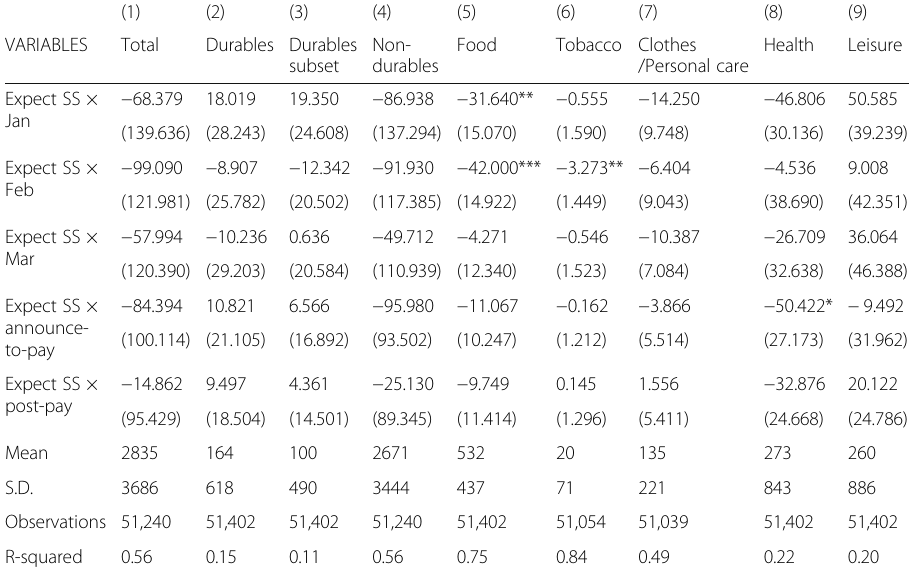
Table 32 Overall impact of expecting to receive SSS payouts on